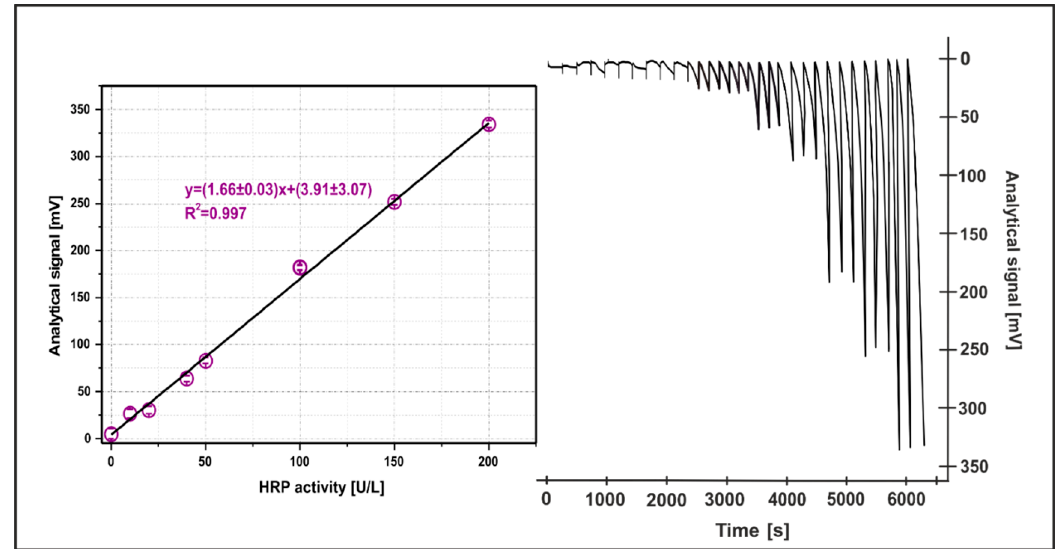
Figure 4. The recording of the calibration process for HRP activity in range of 0–200 U/L under the optimal conditions. The inset shows the corresponding calibration curve. Error bars represent one standard deviation for n = 3.